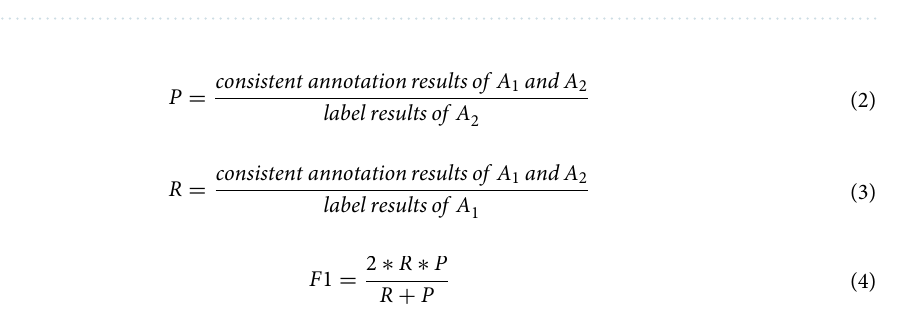
Figure 1. The overall structure of the BERT